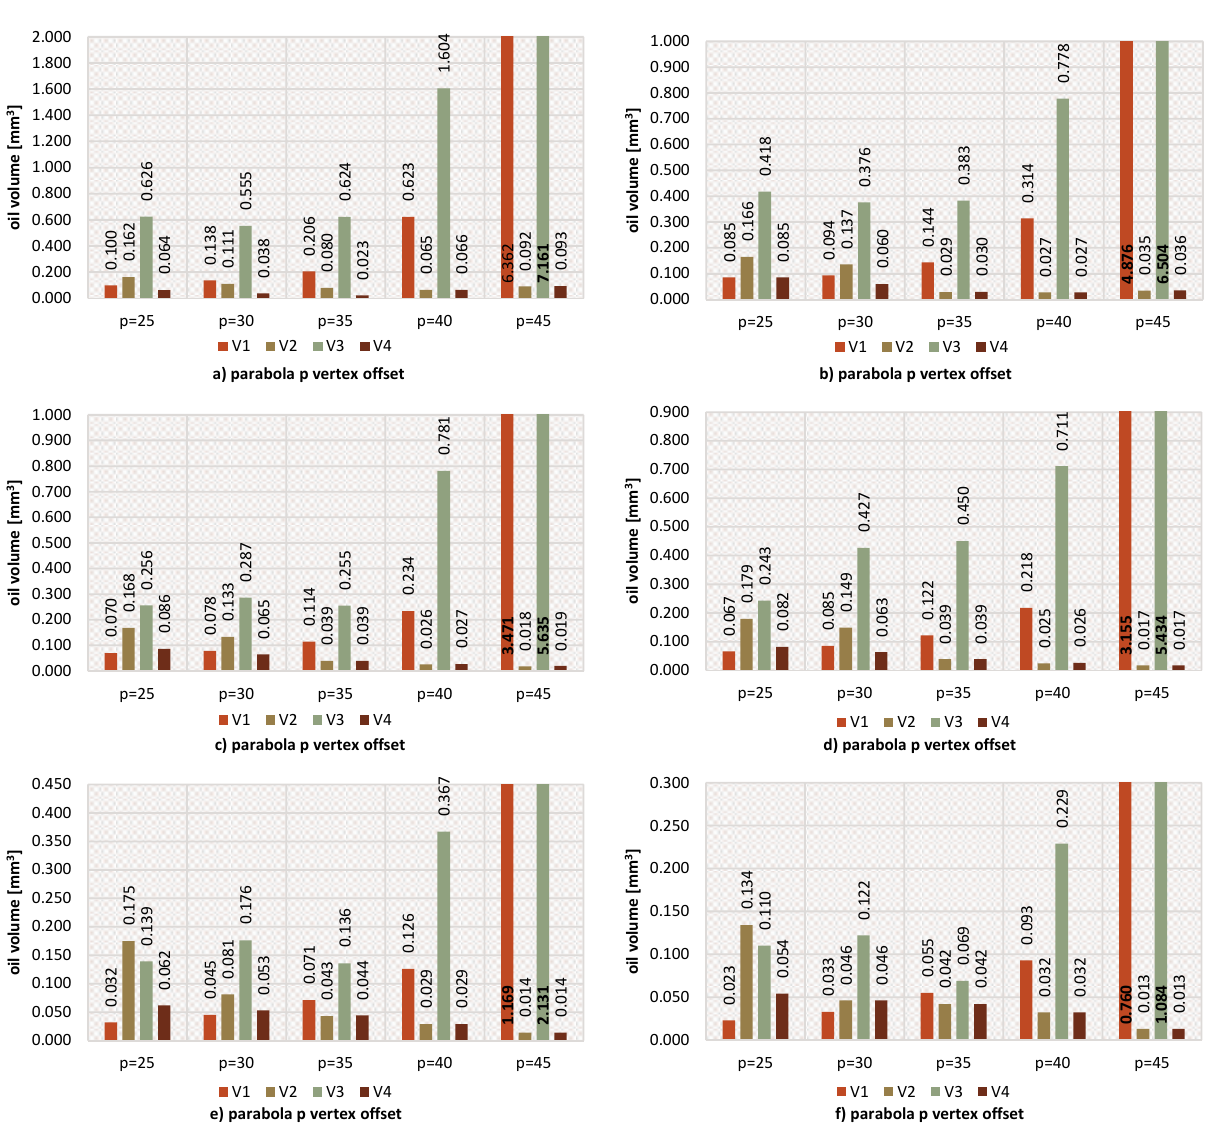
Fig. 5. The volume of lubricating oil scraped into the combustion chamber and crankcase in selected engine running strokes depending on the vertex offset value of the parabola p j,k-1-2 , where: V 1 – intake stroke, V 2 – compression stroke, V 3 – expansion stroke, V 4 – exhaust stroke; a) for 1000 rpm, b) for 2000 rpm, c) 3000 rpm – for the dynamic viscosity of lubricating oil 0.0120 Pa×s, d) for 1000 rpm, e) for 2000 rpm, f) 3000 rpm – for the dynamic viscosity of lubricating oil 0.0386 Pa×s